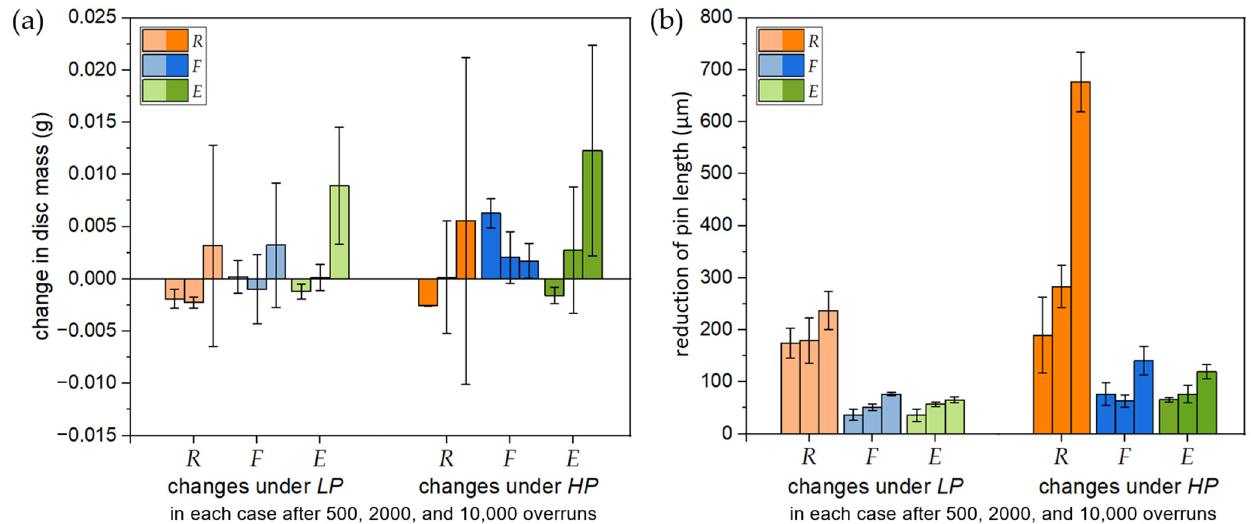
Figure 4. ( a ) The diagram shows the changes in disc mass for every surface condition and test pressure after 500, 2000, and 10,000 overruns. No significant mass changes until 2000 overruns are detectable, except for surface F tested under HP . While the surfaces R (under LP + HP ) and F (under LP ) showed almost no mass changes, a significant mass increase of surface E samples was obtained for LP , as well as for HP after 2000 overruns. ( b ) The average values of the pin-length reduction for the investigated surface conditions and preset pressures show that higher pressure leads, in general, to a larger pin-length reduction. In addition to that, surfaces F and E entail a lower pin-length reduction combined with a smaller standard deviation in comparison to surface R .